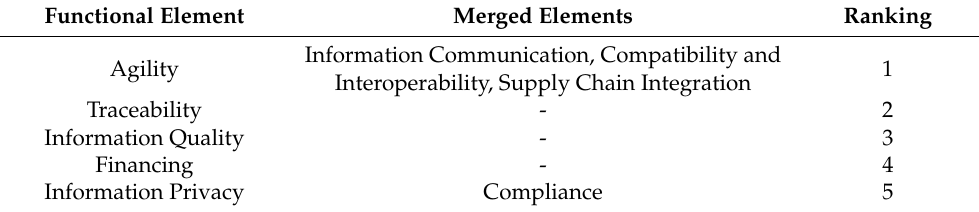
Table 4. List of key functional elements for ICT adoption to optimize retail supply chain performance. Functional Element Merged Elements Ranking Information Communication, Compatibility and Agility Interoperability, Supply Chain Integration